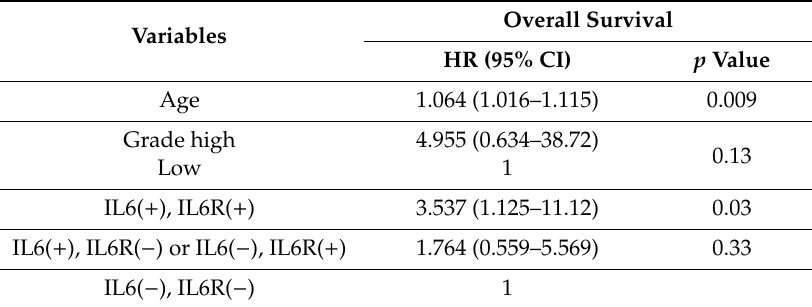
Table 4. Multivariate cox population hazard analysis for overall survival.